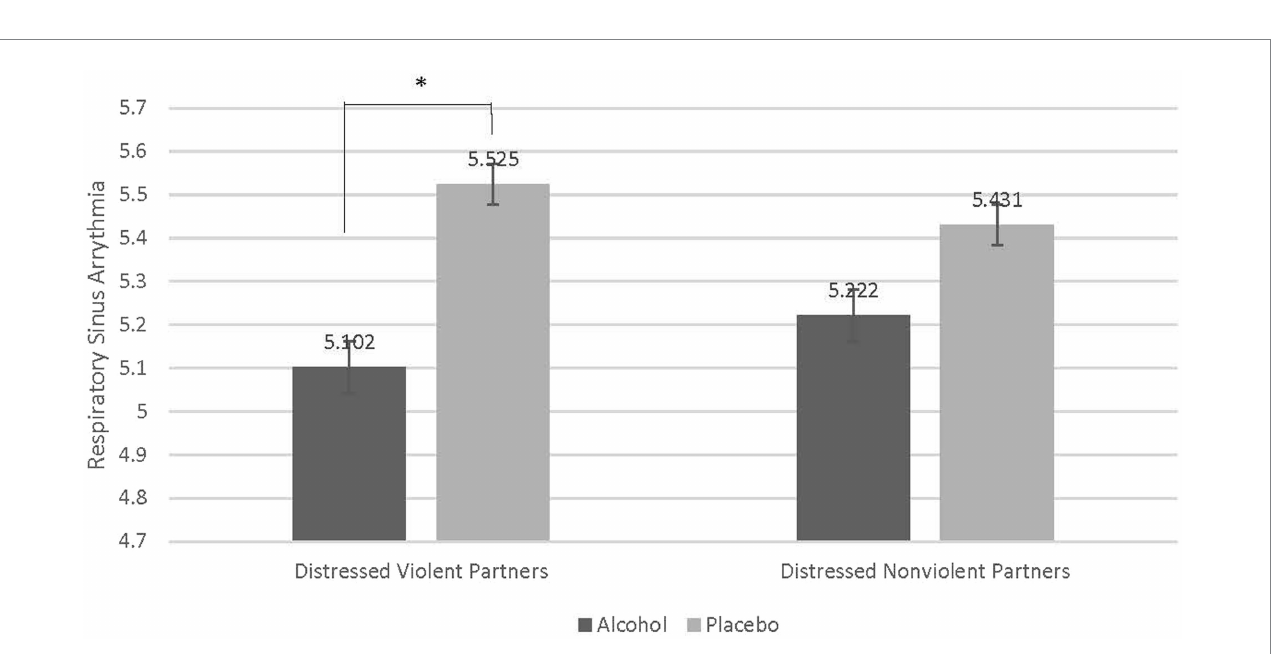
FIGURE 2 Contrast comparing decrease in respiratory sinus arrythmia in distressed violent partners when intoxicated. Compared to distressed nonviolent partners there was a statistically significant difference of the effect of alcohol on respiratory sinus arrythmia (RSA) in distressed violent partners ( M difference = − 0.424, p = 0.017). Acute alcohol intoxication reduced RSA in distressed violent partners to a greater degree than in distressed nonviolent